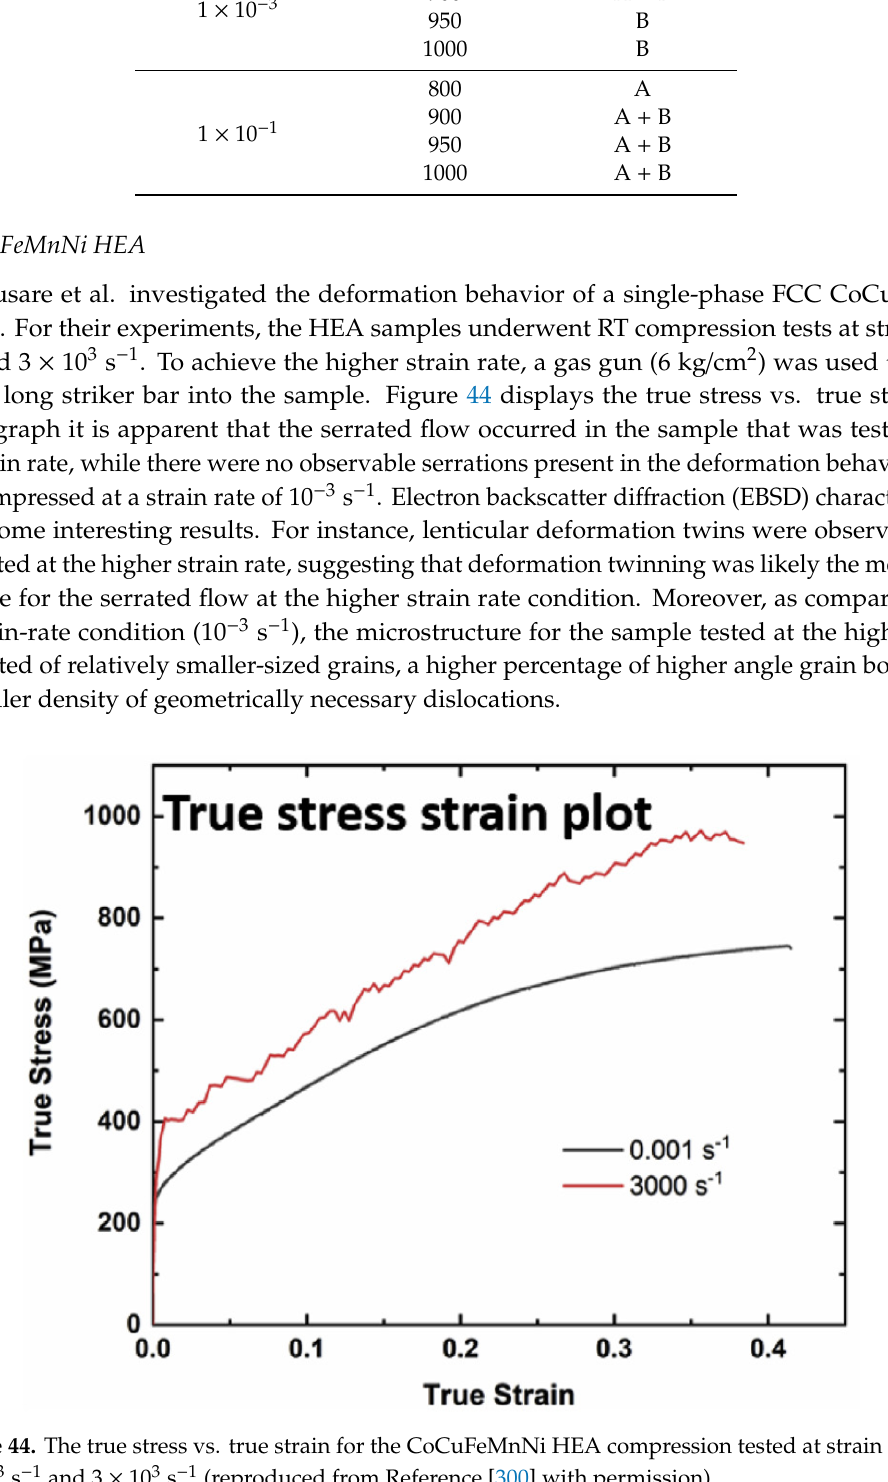
Table 7. Summary of the serration type exhibited by the CoCuFeNiTi HEA during compression at